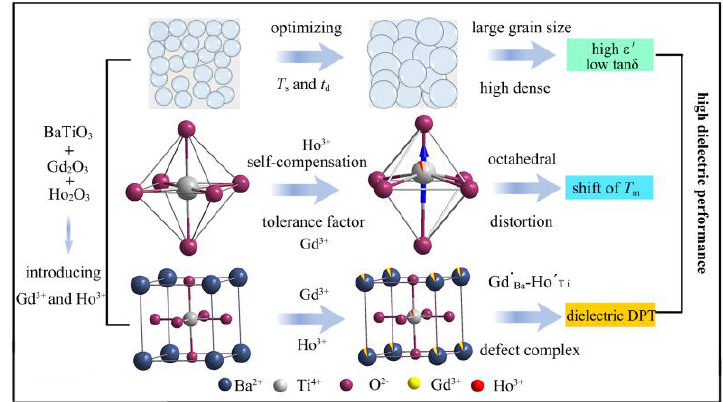
Figure 6. The mechanisms for improving dielectric properties.